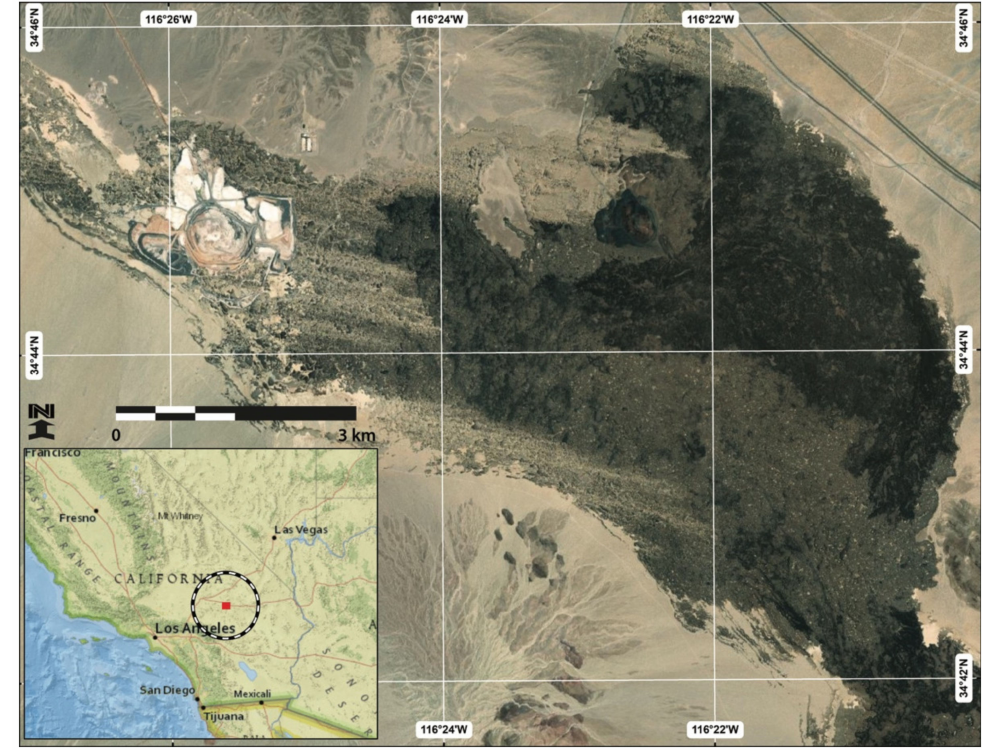
Figure 1. Project study area, Pisgah Lava Field, San Bernardino County, CA,